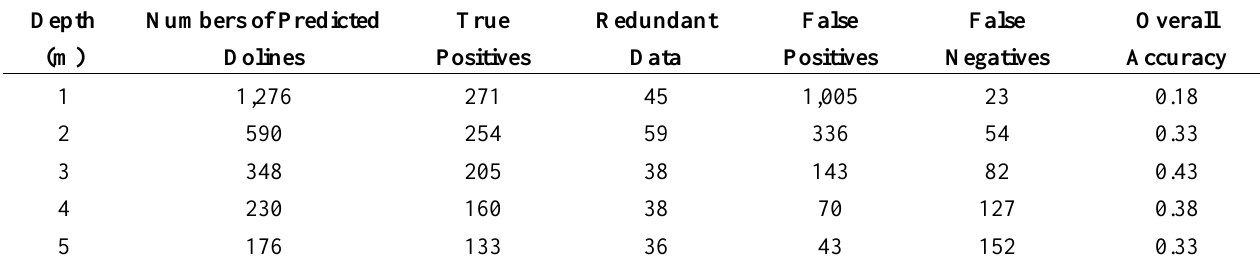
Table 2. Dolines predicted using different threshold values for sink depth from ALOS/PRISM-DEM data. The comparison is made with true dolines (249) obtained by visual